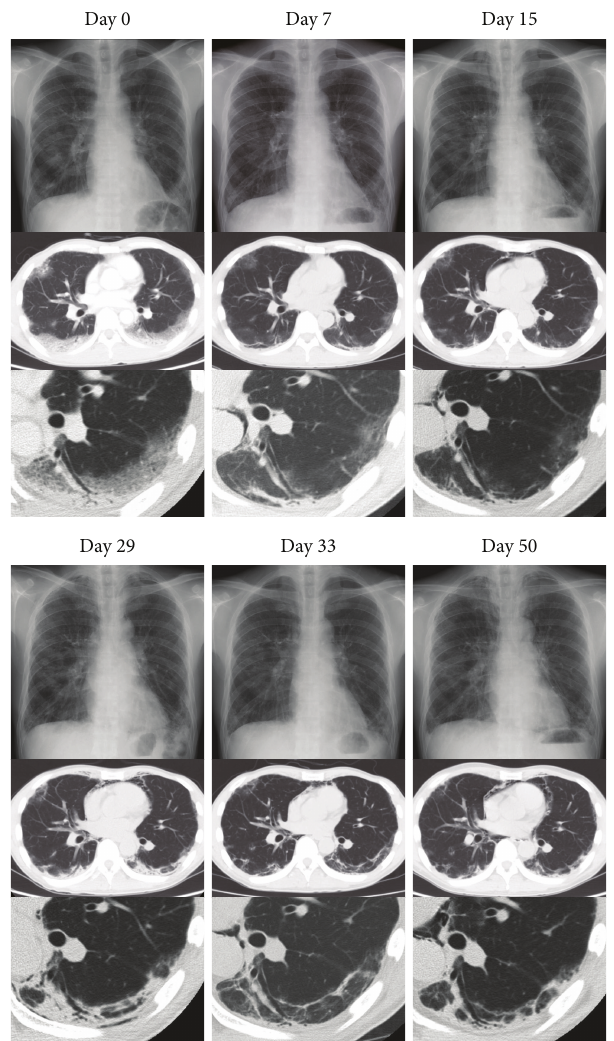
Figure 2: Chest X-rays and computed tomography (CT) scans of the patient with clinically amyopathic dermatomyositis (C- ADM) before and after polymyxin b-immobilized fiber column hemoperfusion (PMX) treatment. Day 0, on admission. Day 7, improvement after initial treatment. Day 15, before relapse. Day 29, on relapse and before PMX treatment. Day 33, improvement after PMX treatment (on days 30 and 31). Day 50, twenty days after PMX